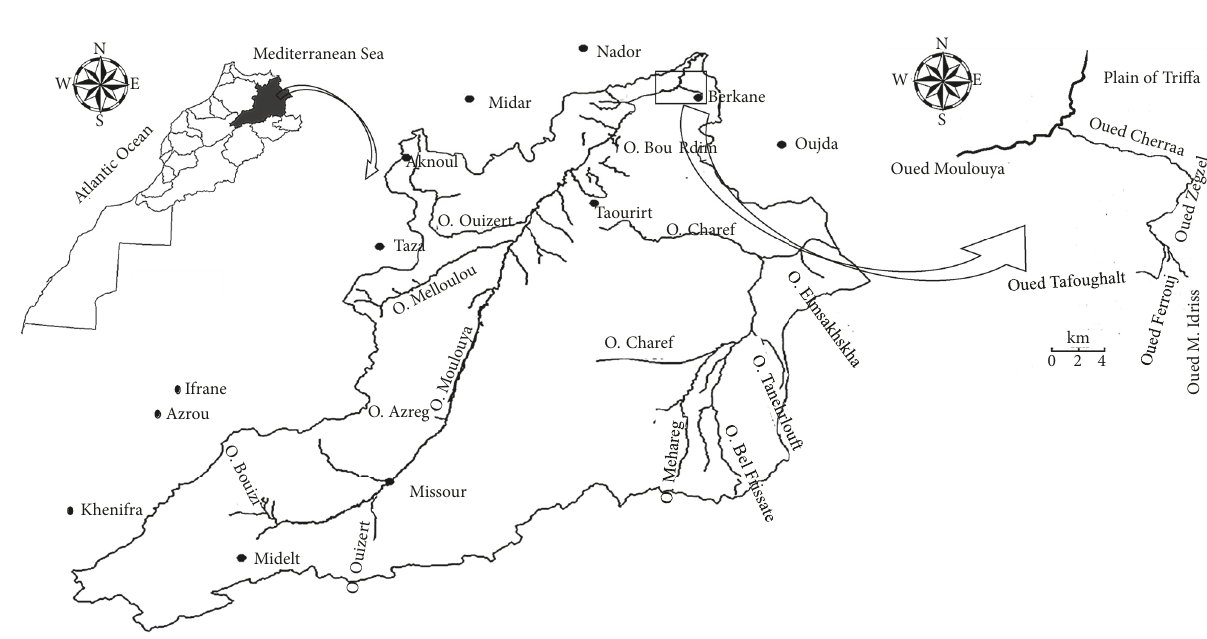
Figure 1: Localization of the study area, Oued Zegzel,